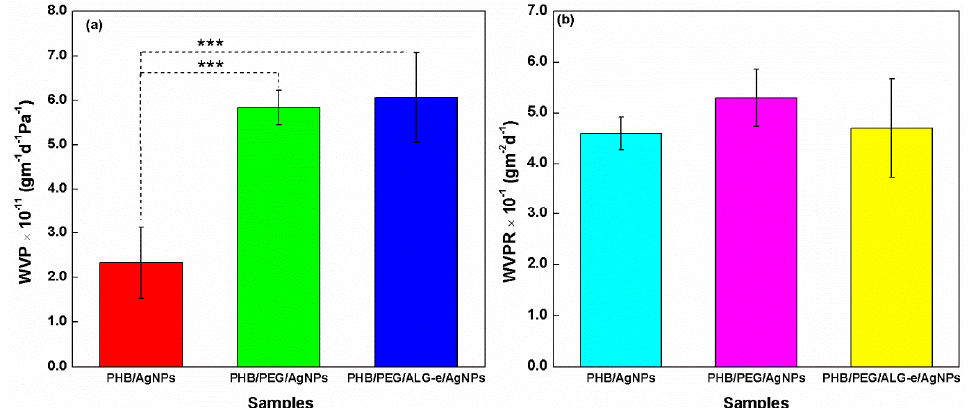
Figure 6. ( a ) Water vapor permeability (WVP) and ( b ) water vapor permeability rate (WVPR) of PHB/AgNPs, PHB/PEG/AgNPs, and PHB/PEG/ALG-e/AgNPs films. *** means that there was statistical difference between the samples with significance level p < 0.001.